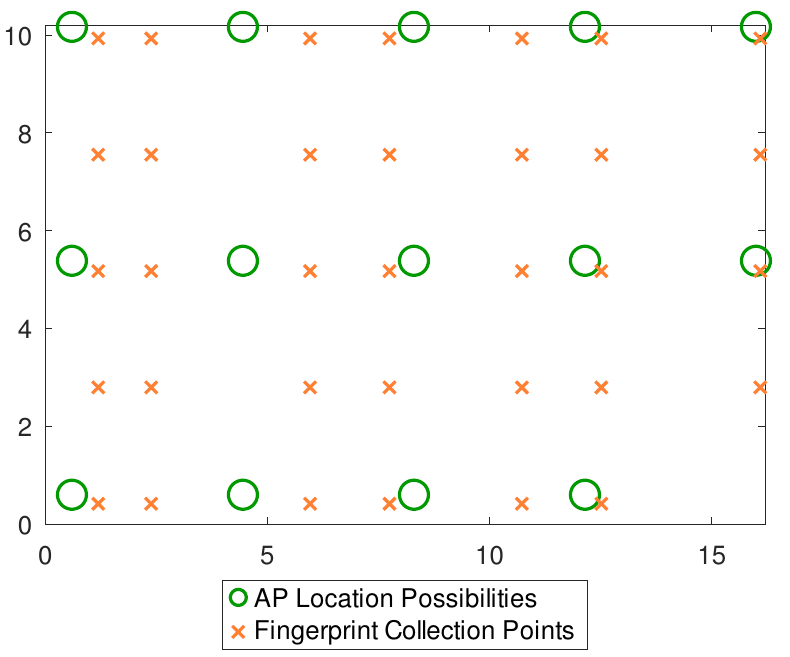
Figure 12. Geotec scenario with 14 possibilities for the APs to be allocated and 34 fingerprint collection